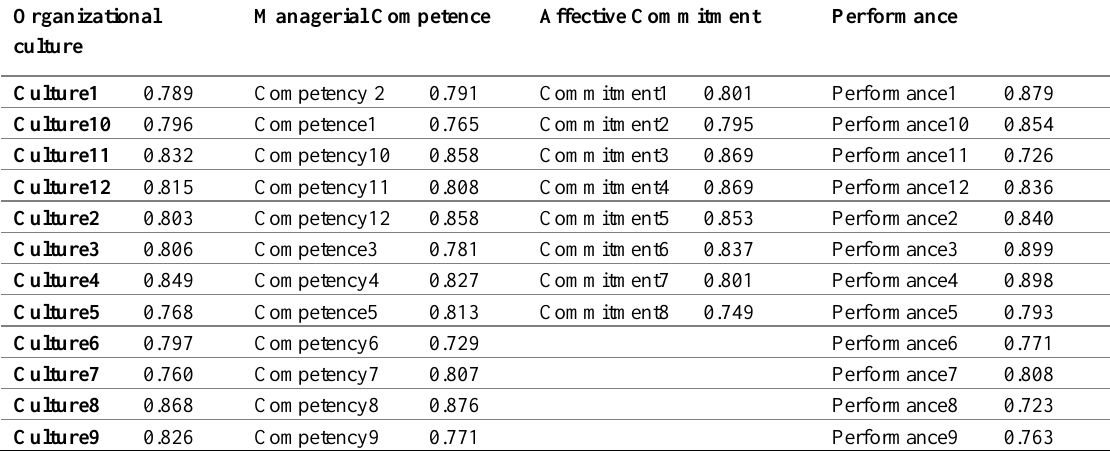
Table 13: Outer Loading Value (loading factor)